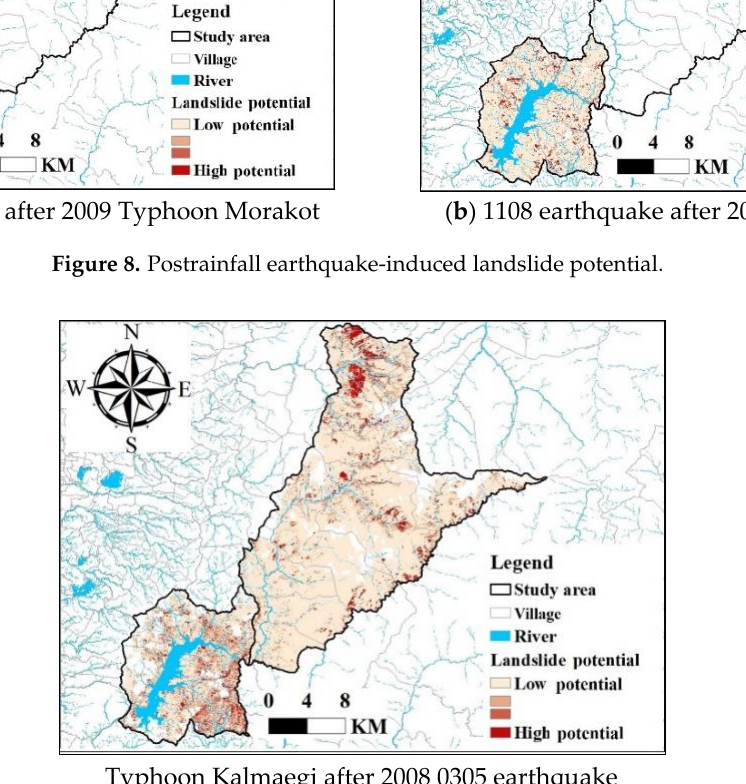
Figure 9. Postearthquake rainfall-induced landslide potential.